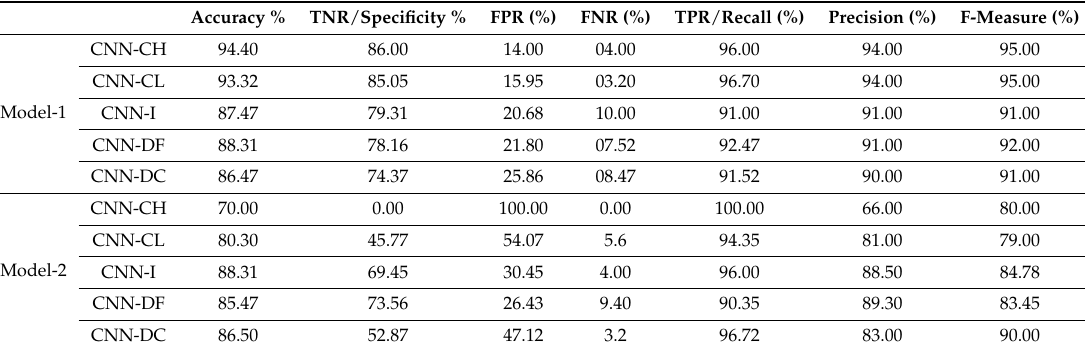
Table 3. Performance of various cases on 40 ×